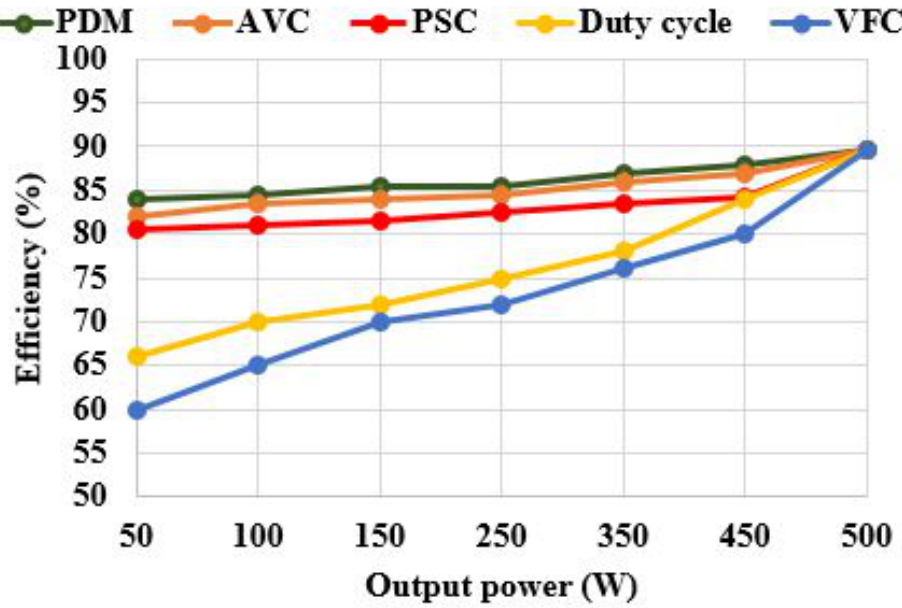
Figure 13. Efficiency of various control